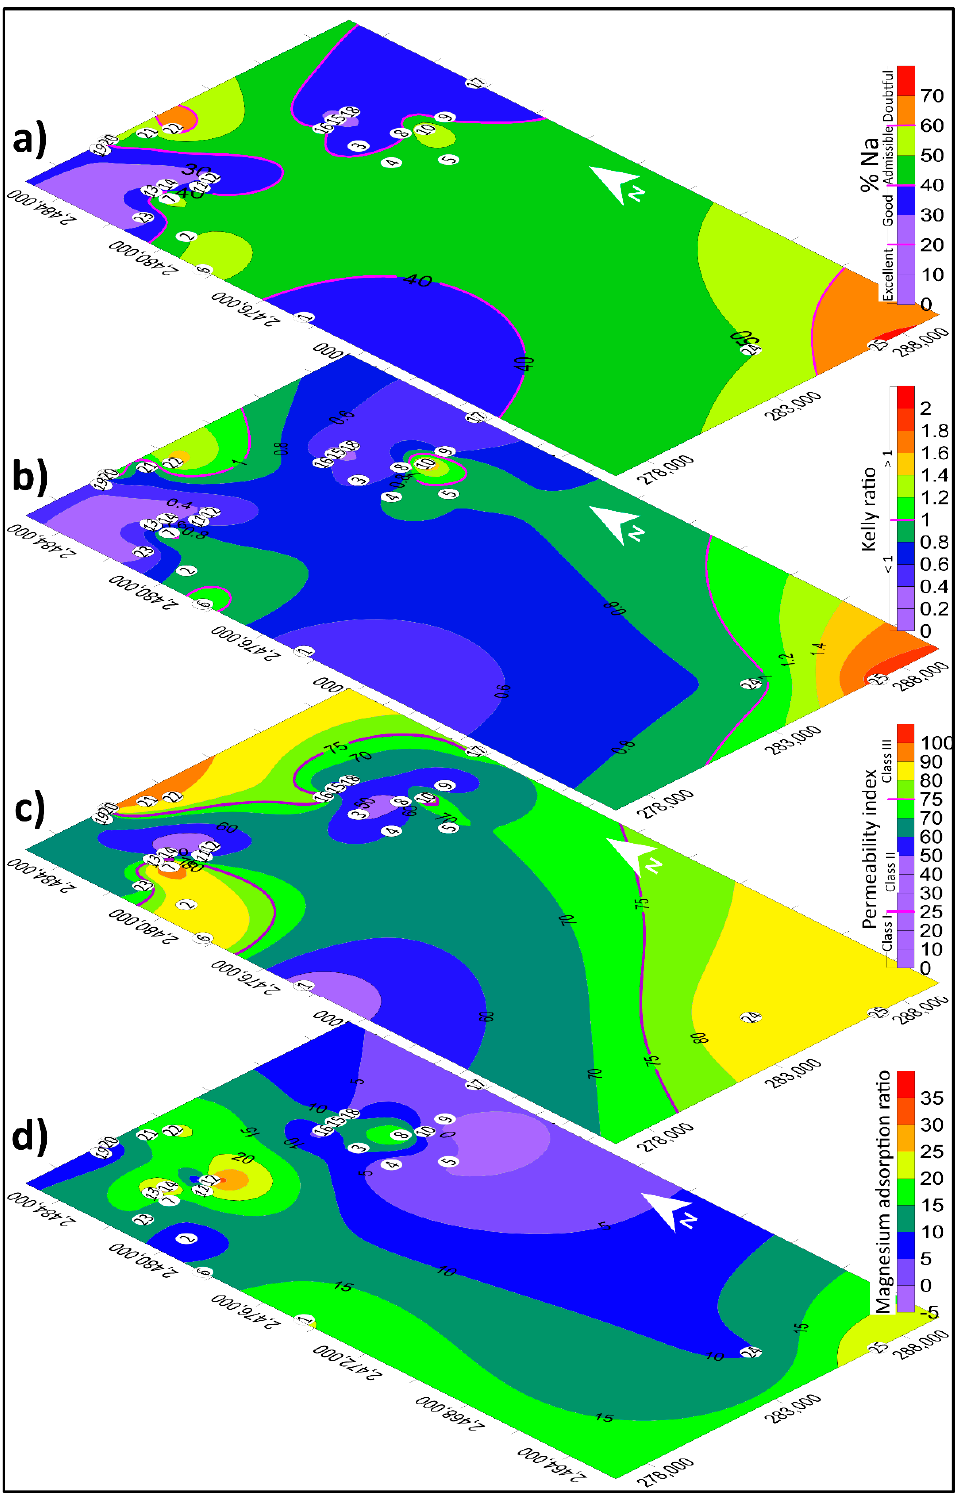
Figure 6. Spatial distribution of the indices in the study area ( a ) % Na, ( b ) KR, ( c ) PI, and ( d ) MAR.